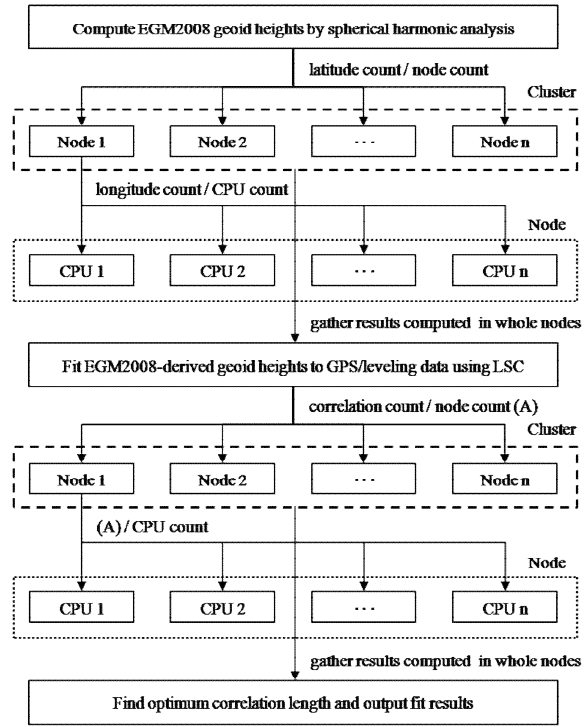
Figure 2. Parallelization model flow chart of SHA and LSC